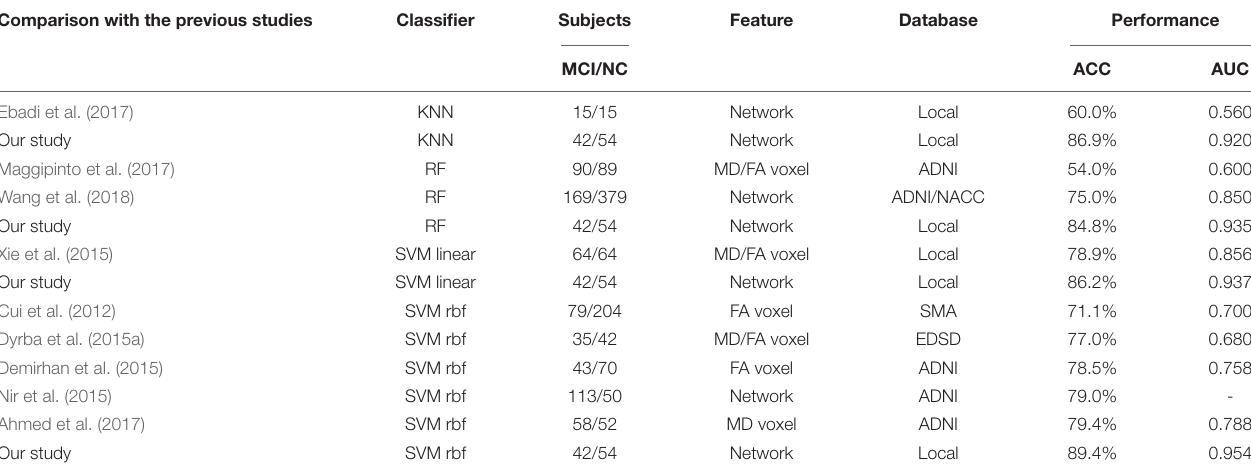
TABLE 5 | Summary of the studies using dMRI features for MCI classification. Comparison with the previous